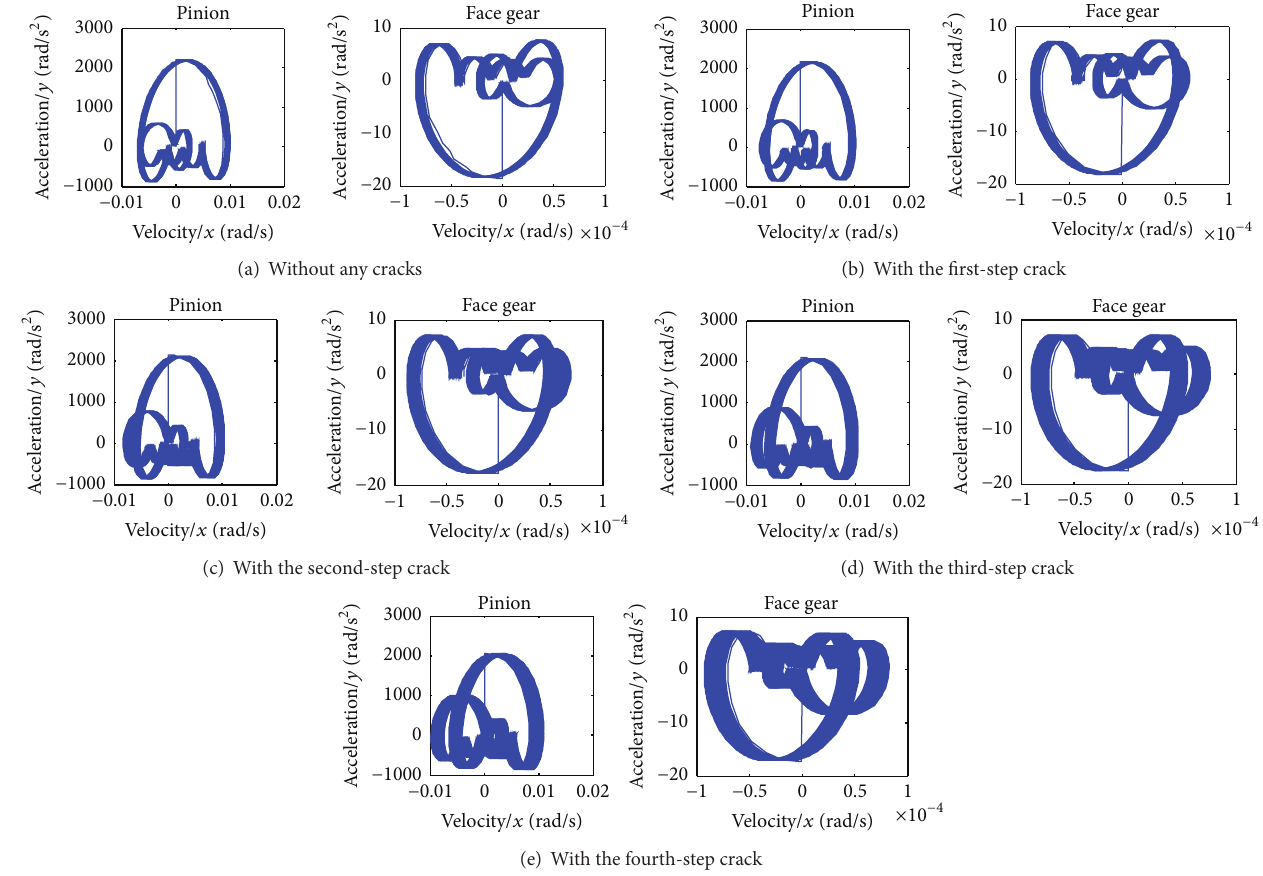
Figure 11: The simulations of the dynamic behaviors of the example